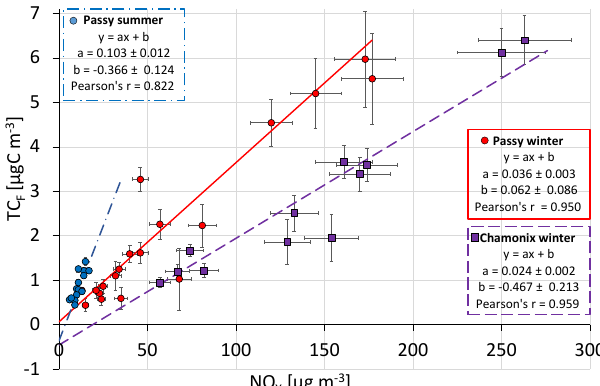
-1 Figure 8. Comparison of TC F , based on 14 C / 12 C ratio measure- ments, with NO x . TC F corresponds to the carbon concentration multiplied by f F . For the winter samples, f F is determined for p bio = 0 and for summer samples p bio = 1. It has to be under- lined that a variation in p bio does not affect the significance of the relationship between levoglucosan and TC NF (see Table 5). Pur- ple squares denote Chamonix winter samples, red dots denote Passy winter samples, and blue dots designate Passy summer samples. Each dataset exhibits a good correlation between NO x and TC F concentrations. The fit parameters have been calculated by taking into account both error bars on the x and y axes and are given with their 95% confidence interval. A higher slope value is obtained for the summer datasets than for the winter ones, which suggests either different fossil carbon sources or NO x degradation rate depending on the